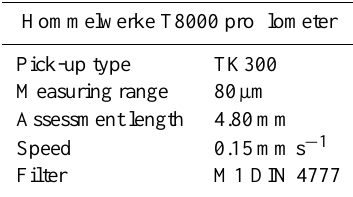
Table 1. Characteristics of roughness measurement machine.